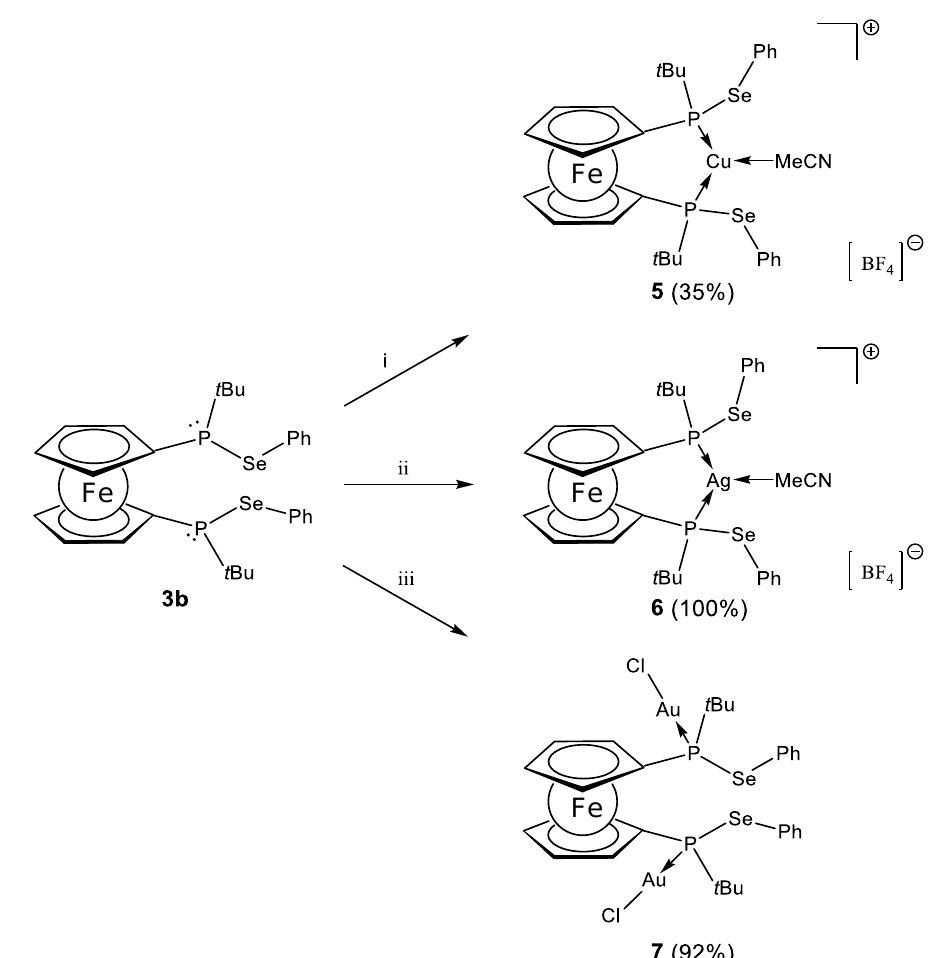
Scheme 3. Formation of coinage metal complexes with bisselenophosphinous acid phenylester